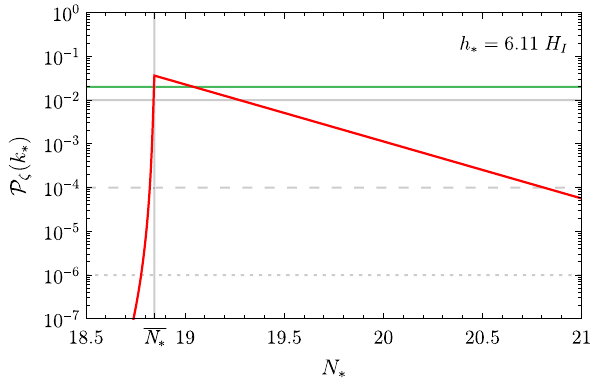
Fig. 2 Evolution of h c and its perturbation δ h k for the case N ∗ > N ∗ (or equivalently h ∗ > h ∗ ; see the text for details)